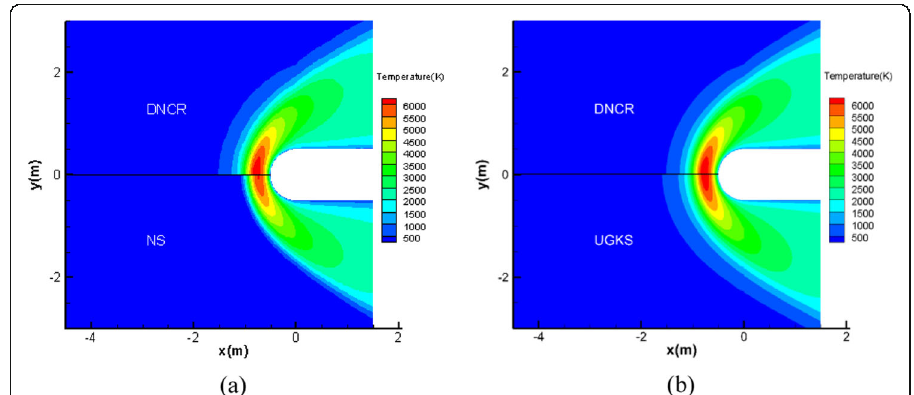
Fig. 10 Temperature contours of DNCR and NS solutions